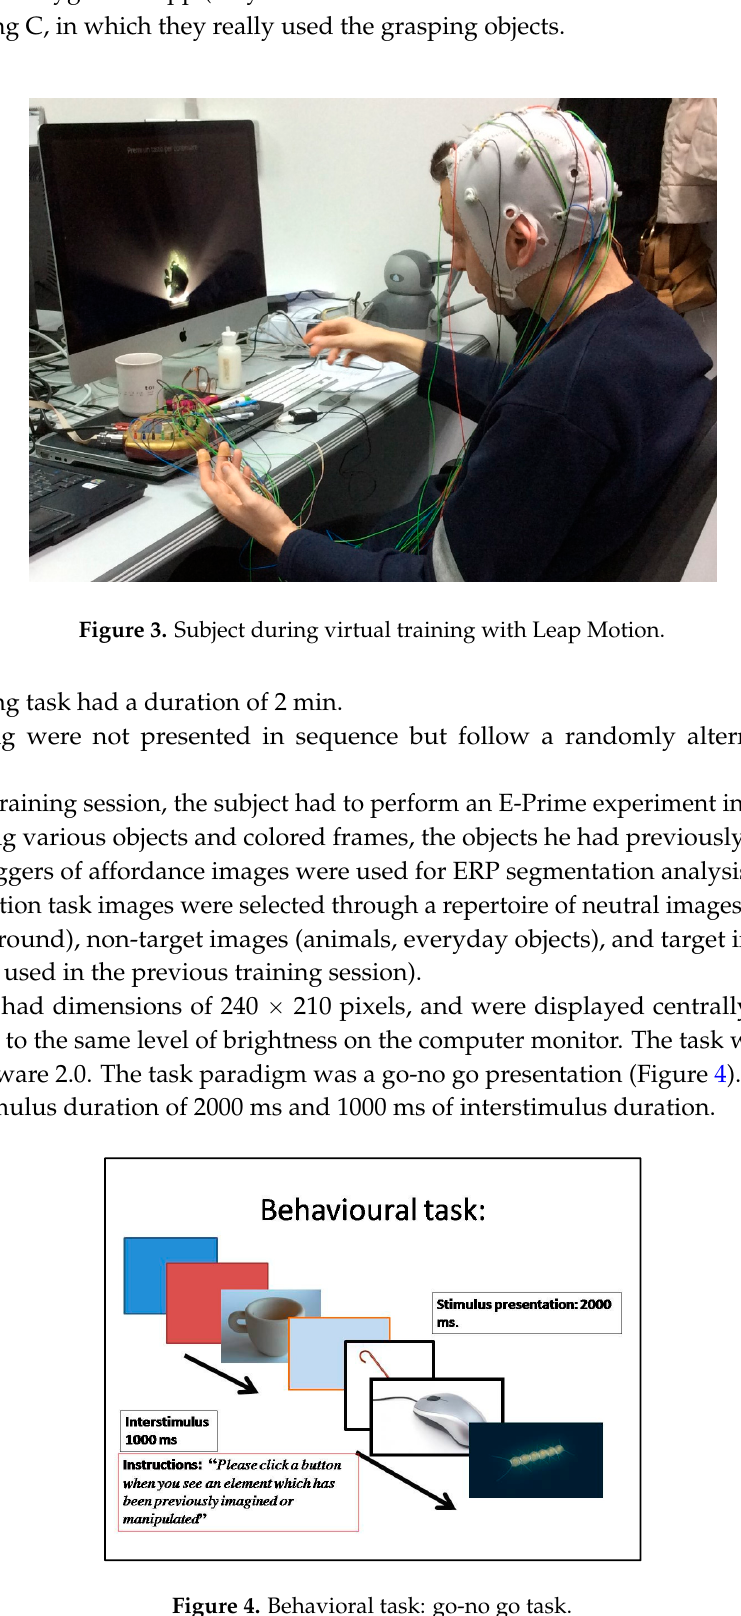
Figure 4. Behavioral task: go-no go task.